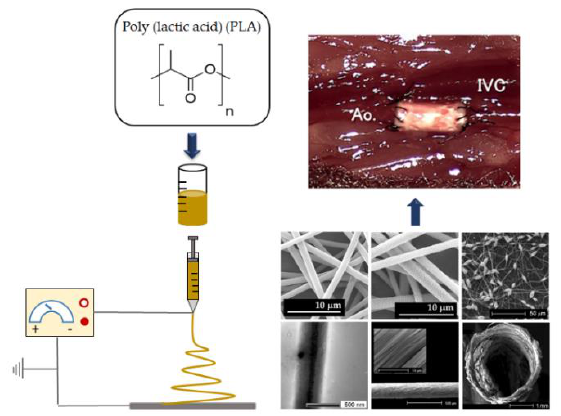
Figure 1. Schematic to explain the recent progress in electrospinning diverse PLA-based structures, with a focus on their biomedical applications (IVC: inferior vena cava; Ao: aorta).